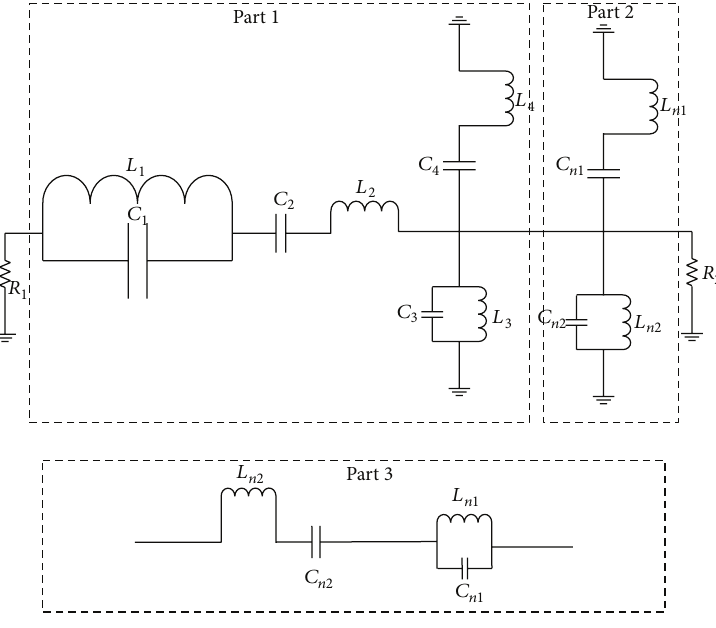
Figure 8: Equivalent circuit of the proposed patch